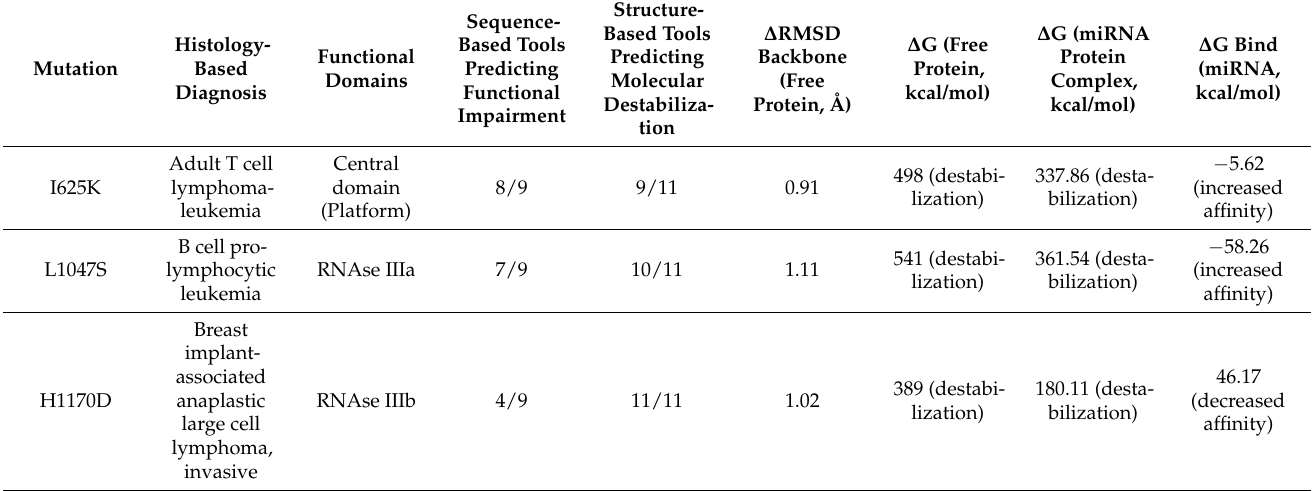
Table 5. Summary of I625K, L1047S, and H1170D effect evaluation. Histology-based diagnosis was obtained from the COSMIC database. Functional domains were described in Kwon et al., 2016. Shifts in backbone RMSD and corresponding energies are calculated as follows: value wild-type –value mutant